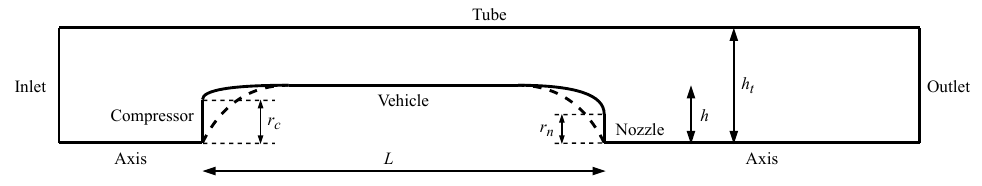
Figure 2. Schematic domain for the compressor case. Not to scale.